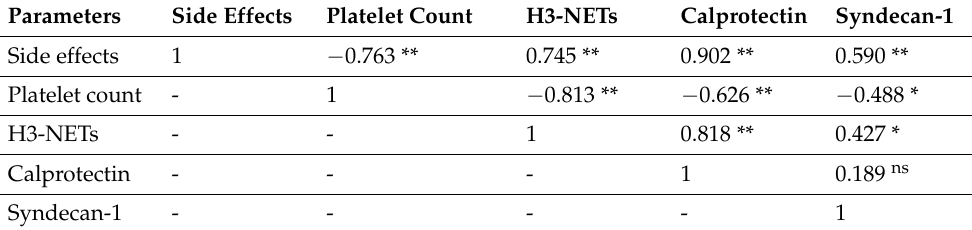
Table 3. Correlations between values for inflammatory markers in ChAdOx1-vaccinated subjects with VITT, prolonged severe or brief mild symptoms and side effects degree Pearson correlation coefficient